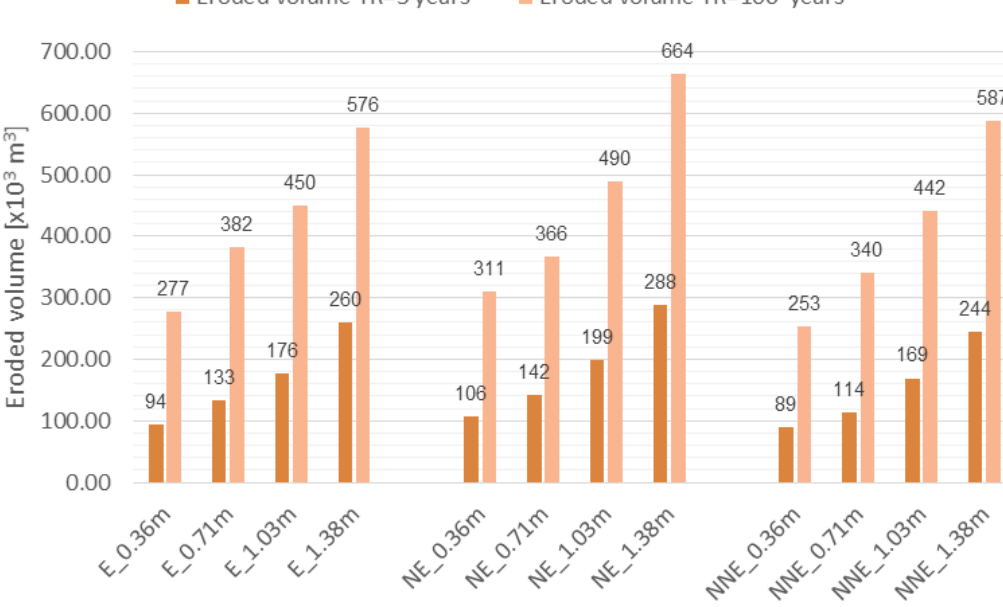
Figure 13. Cumulative sand eroded volumes corresponding to future climate scenarios for each of the studied combinations of storm direction, return period and sea level (legend: [storm direction] _ [sea level]).